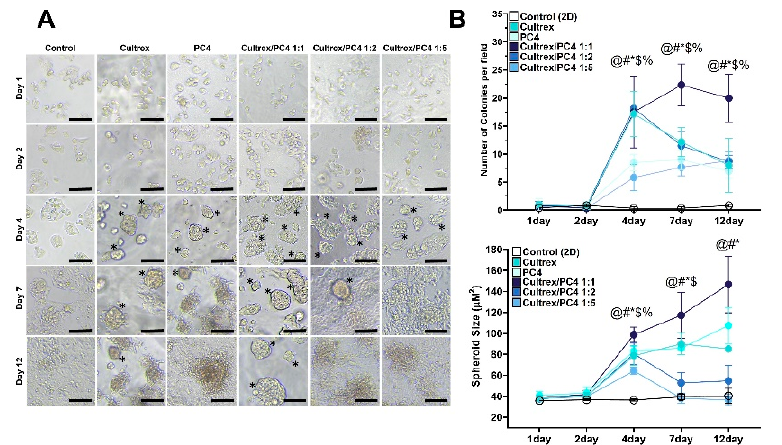
Figure 5. Effect of hydrogels on the growth and size distribution of HepG2 spheroids. Cells were grown in different hydrogels or control (2D) condition. The number and size distribution were determined at day each time point from day 1 to 12. ( A ) Bright field images to monitor the growth of HepG2 spheroids in size and number. Black asterisks indicate cell aggregates of diameter larger than 35 µm that were considered spheroids. Scale bars = 100 µm. ( B ) Comparison of numbers and mean diameter of HepG2 spheroids over 12 days. @ indicates Cultrex compared with control (2D). # indicates PC4 compared with control (2D). * indicates Cultrex/PC4 1:1 compared with control (2D). $ indicates Cultrex/PC4 1:2 compared with control (2D). % indicates Cultrex/PC4 1:5 compared with control (2D). Data are expressed as the mean ± SD of 10 images in each condition. @, #, *, $, % p < 0.05.